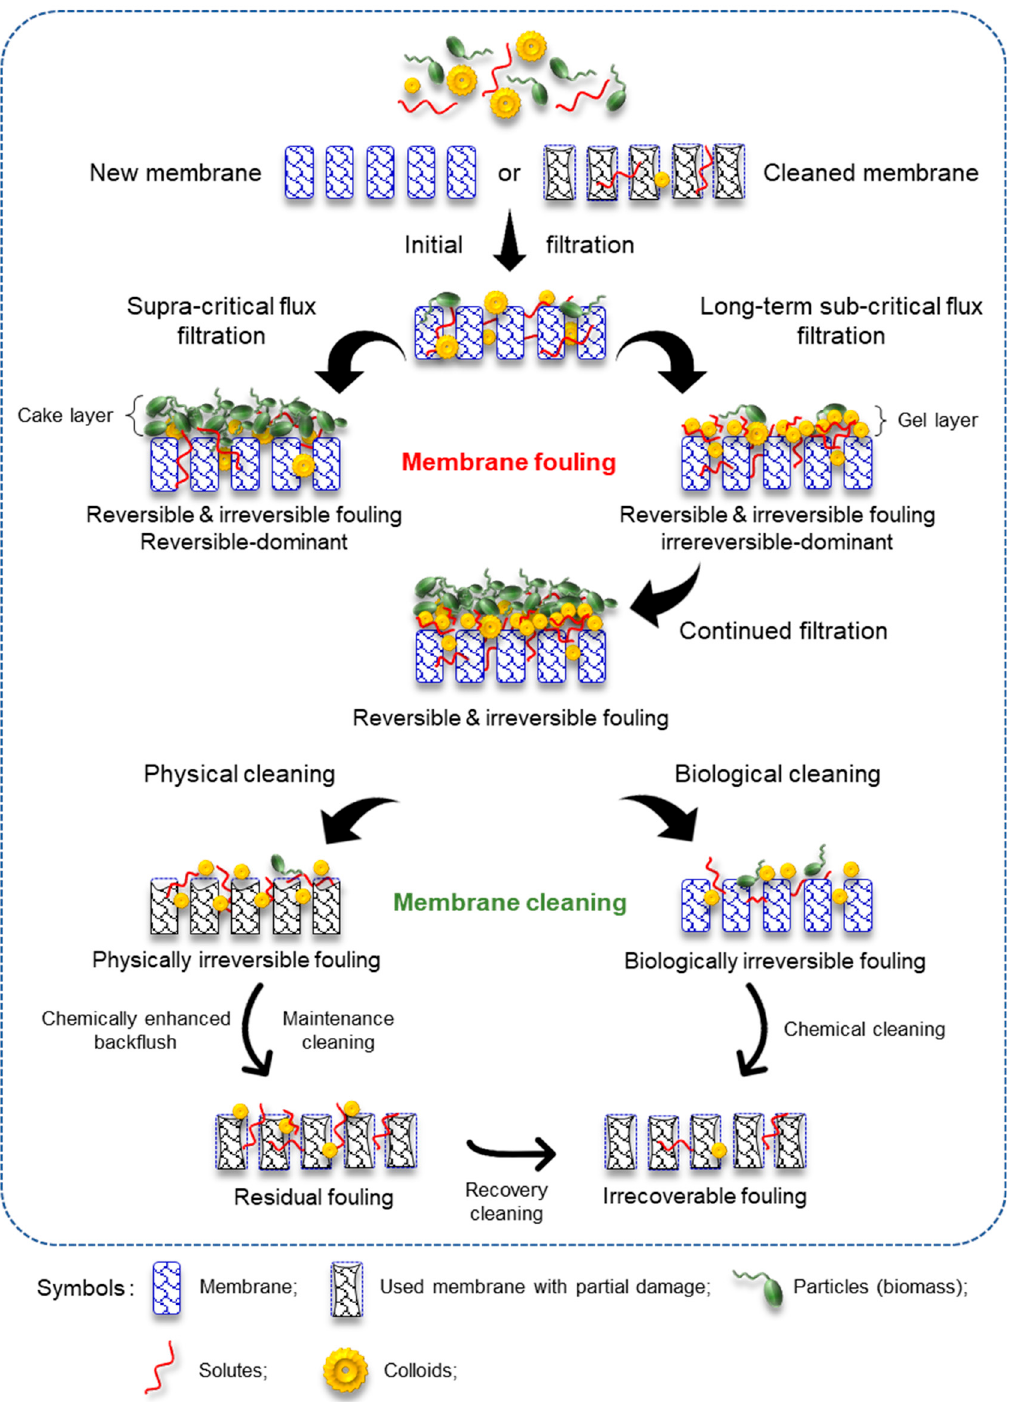
Figure 2. Overview of membrane fouling types, mechanisms and the required cleaning techniques.